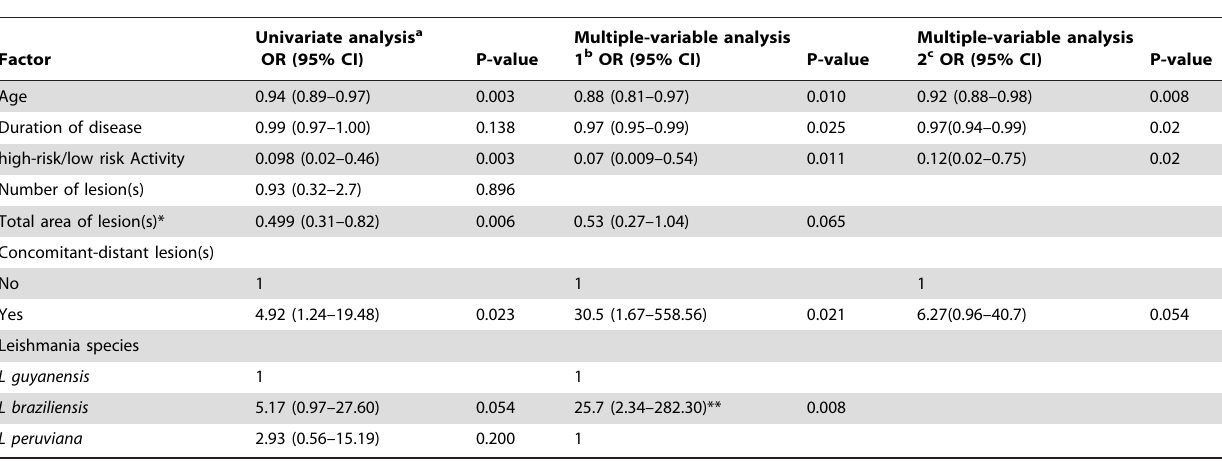
Table 2. Logistic regression models to predict antimony treatment failure of ulcerative cutaneous leishmaniasis.